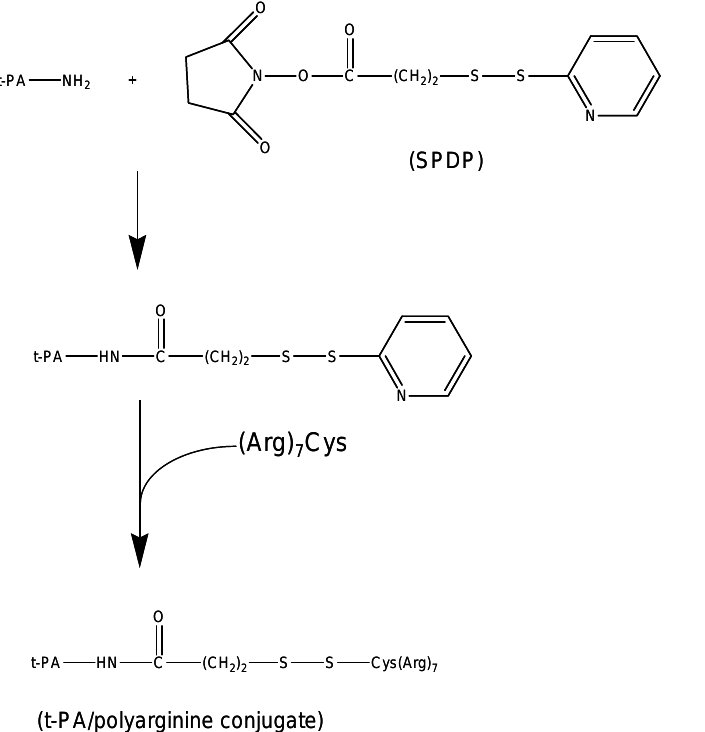
Figure 11. The synthesis of modified t-PA with t-PA and poly((Arg) succinimidyl-3-2-pyridyldithio propionate (SPDP) (adapted from the manuscript by Liang et al.